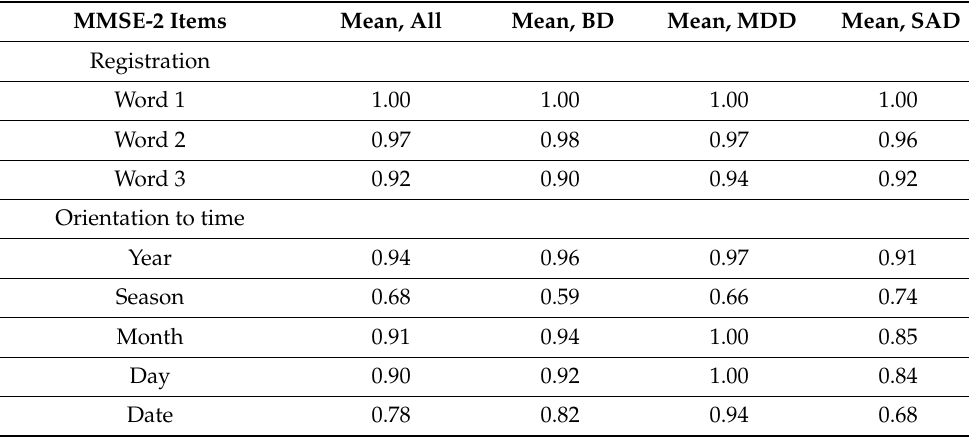
Table 4. Item difficulty: Total sample and by